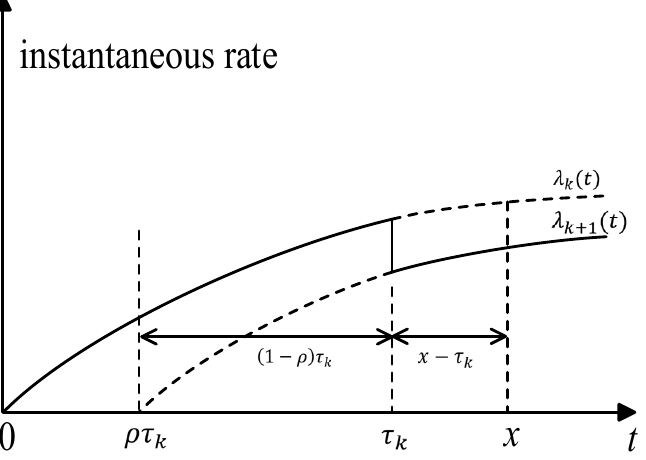
Figure 2. Illustration of the accumulative age.